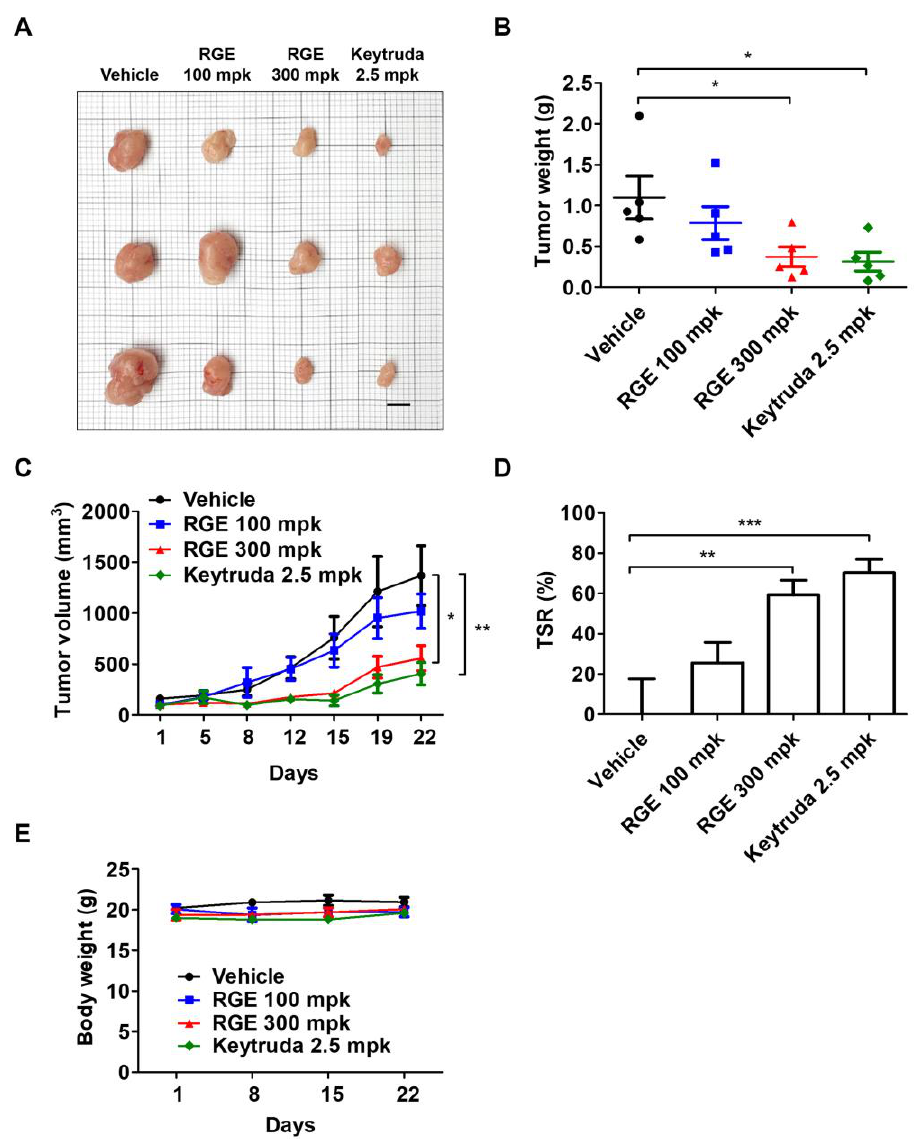
Figure 3. Antitumor effect of RGE in a human PD-1/PD-L1 MC38 cell allograft mouse model. ( A ) Images of the harvested tumor tissues in vehicle, RGE 100, 300 mg/kg, and Keytruda (anti-PD-1) 2.5 mg/kg groups on day 22 (n = 3, bar indicates 1 cm). ( B ) Tumor weight on day 22. ( C ) The growth curve based on tumor volume over 22 days. ( D ) Tumor suppression rate on day 22. ( E ) Body weight (grams) over 22 days. Data are presented as the mean ± SD, * p < 0.05, ** p < 0.01, *** p < 0.001 compared with the control.